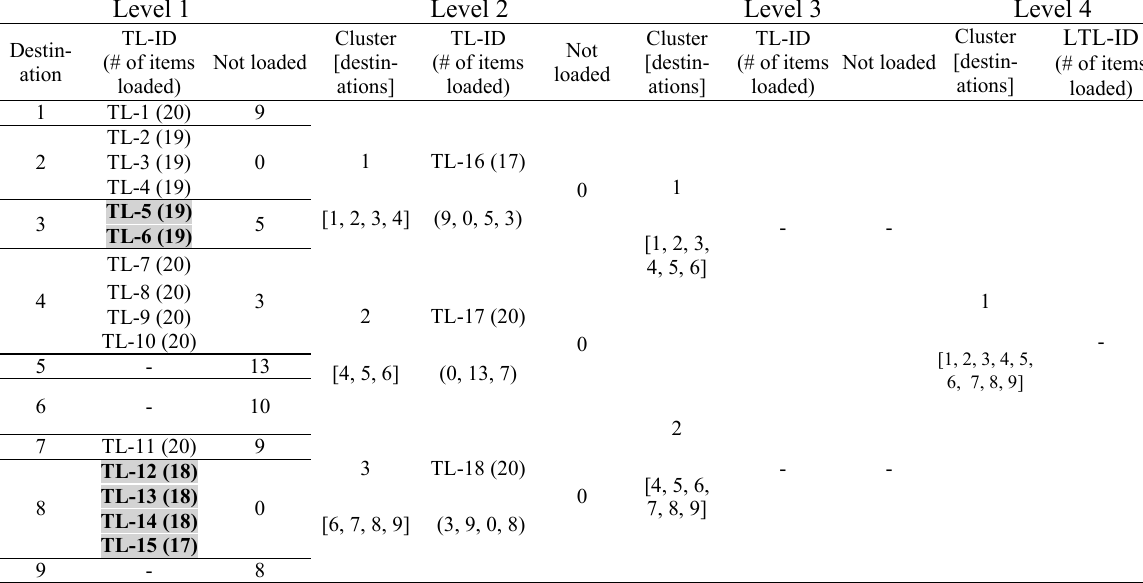
A truck-loading decision with 18 trucks for the example problem